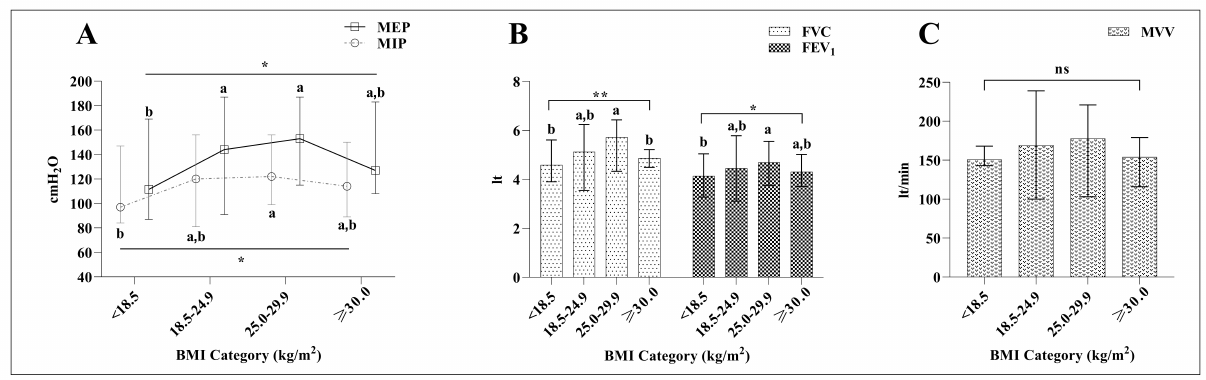
Fig. 1. Respiratory muscle strength and pulmonary functions according to BMI categories in athletes [ < 18.5 ( n =10) ; 18.5– 24.9 ( n =190) ; 25.0–29.9 ( n =23) ; ≥ 30.0 ( n =8) ]. All data were expressed as median (min–max). (A) Respiratory muscle strength. (B,C) Pulmonary functions (n = 231). a,b No significant differences between groups that share the same letter. ** p < 0.001; * p < 0.05; ns, non-significant; MIP, Maximal inspiratory pressure; MEP, Maximal expiratory pressure; FVC, Forced vital capacity; FEV 1 , Forced vital capacity at 1 second; MVV, Maximal voluntary ventilation.